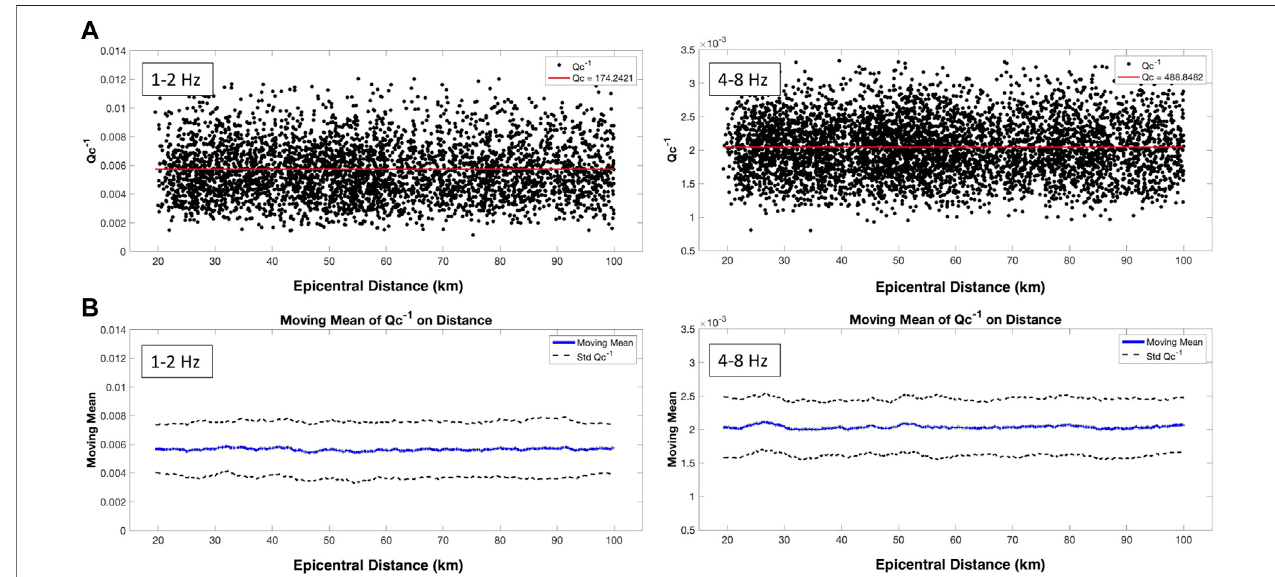
FIGURE5|(A) Q c − 1 asafunctionofepicentraldistanceatf c =1.5and6 HzintheCentralApenninesobtainedfromthe2016 – 2017dataset.Thelengthofthecoda windowis fi xedto20 s,anditsonsettimestartsattwicethearrivaltimeoftheS-wavearrival,2tS. (A) Blackdotsareforeachwaveformobtainedfromthelinearapproach approximation in Eq. 4 . The red line represents the average Q c − 1 . (B) The blue line is the moving mean of the Q c − 1 in (A) , the black lines are its standard deviation.